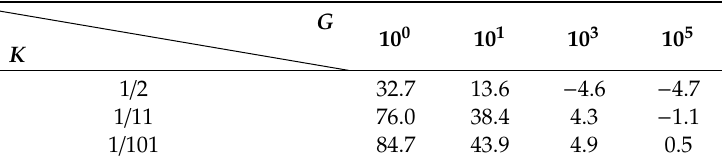
Table 2. The maximum deviations between Higuchi’s model and this present model for n = 2 / 3 (% fraction of released